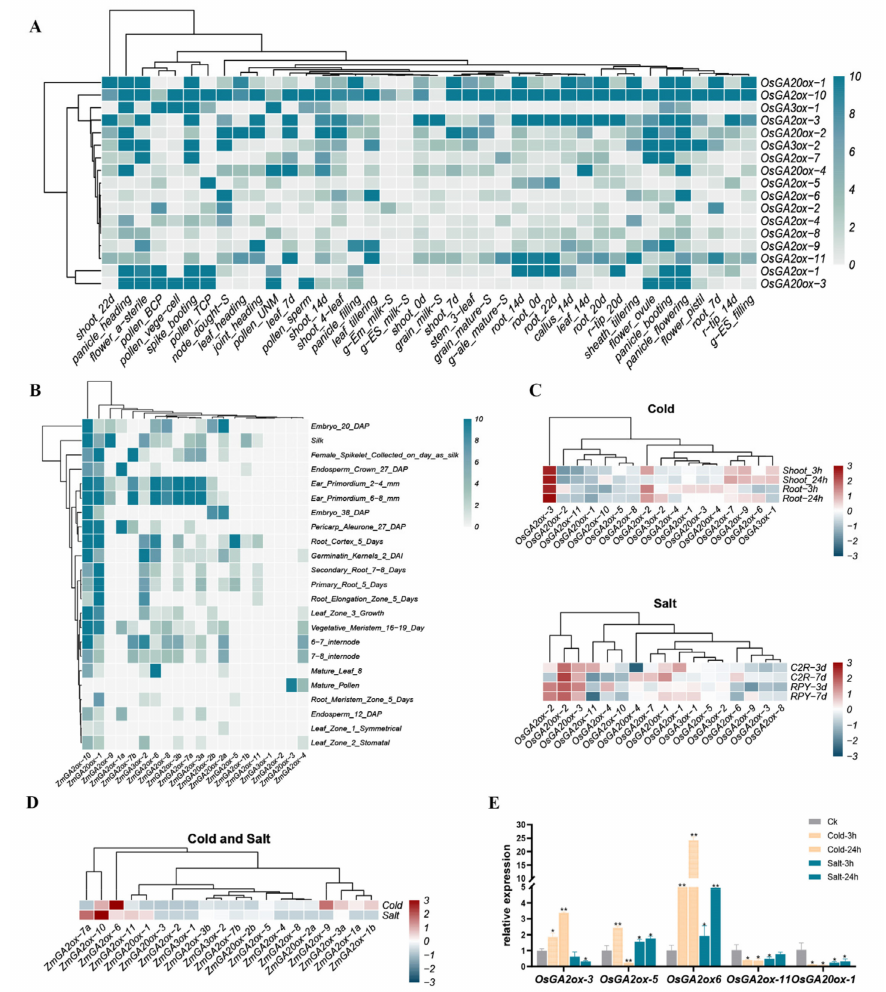
Figure 5. Analysis of the expression pattern of GAox genes. ( A ) Expression profiles of OsGAox genes in various tissues of rice. ( B ) Expression profiles of ZmGAox genes in various tissues of maize. ( C ) Expression profiles of GAox genes in rice under cold and salt stress. ( D ) Expression profiles of GAox genes in maize under cold and salt stress. ( E ) Relative expression profiles of five